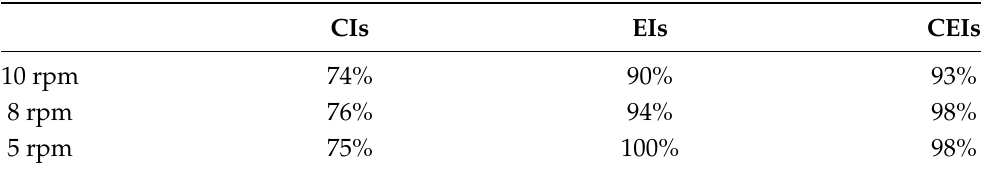
Table 3. Accuracy score of random forest classifier by the use of classic indicators (CIs), entropy indicators (EIs), and classic and entropy indicator (CEIs) for signals at 5, 8, and 10 rpm. CIs EIs CEIs